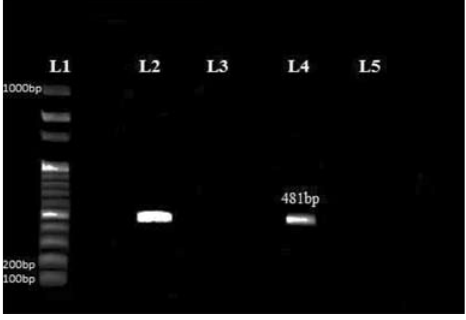
Fig. 1. Agarose gel electrophoresis picture showing 481 bp PCR amplified product of PCV-2 (lane 1-DNA ladder; lane 2-positive control; lane 3-negative control; lane 4 –positive sample; Lane 5 – negative sample) Fig. 2 . Kidney showing few white areas with multi-focal pinpoint haemorrhages